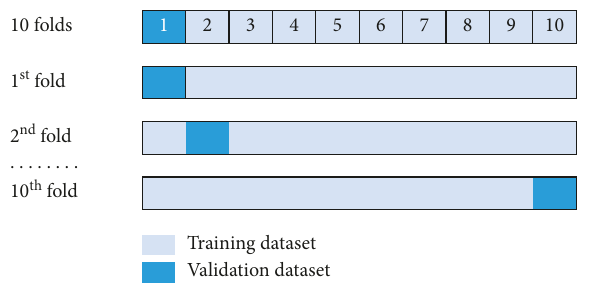
Figure 5: K-folds